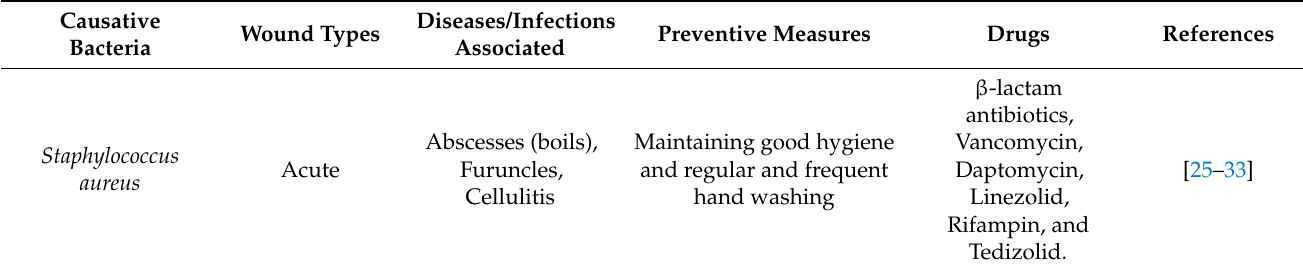
Table 1. The description of some common wound infections and their traditional treatments.